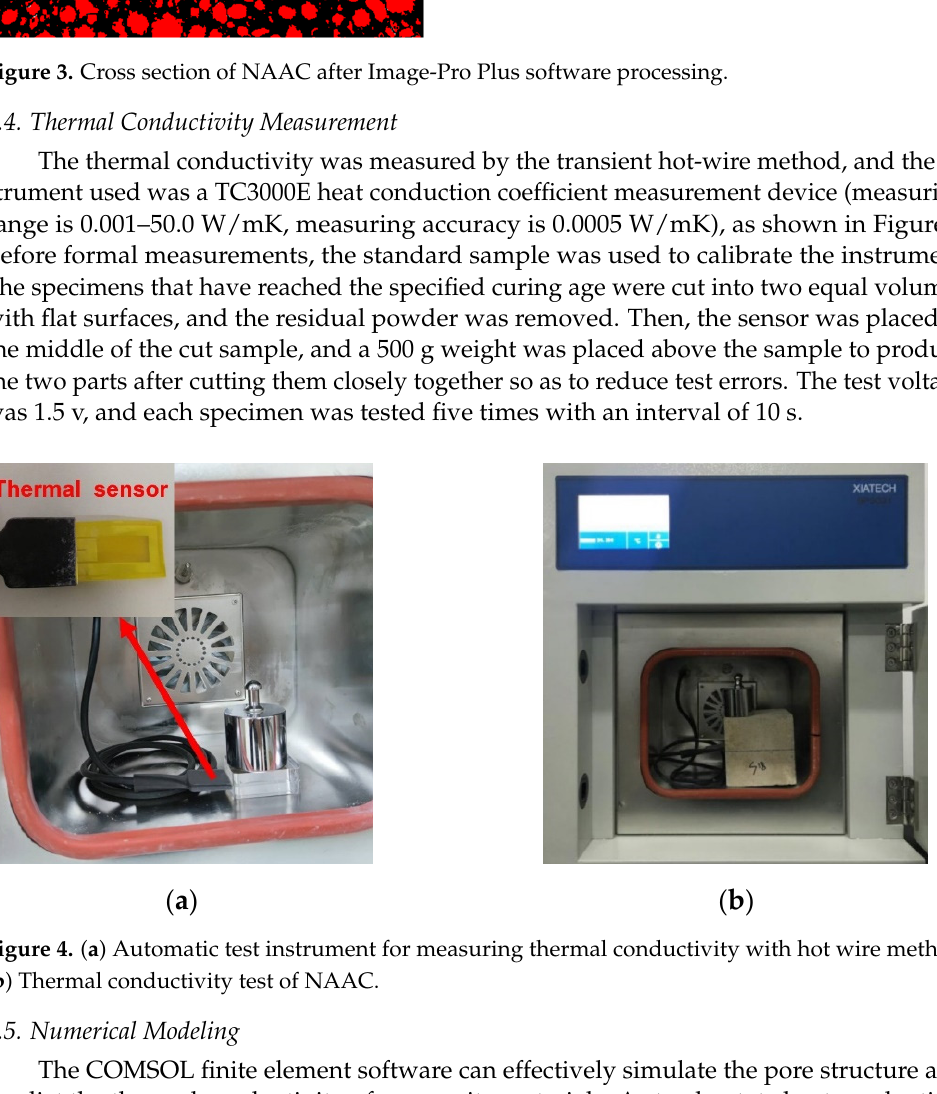
Figure 4. ( a ) Automatic test instrument for measuring thermal conductivity with hot wire method; ( b ) Thermal conductivity test of NAAC.